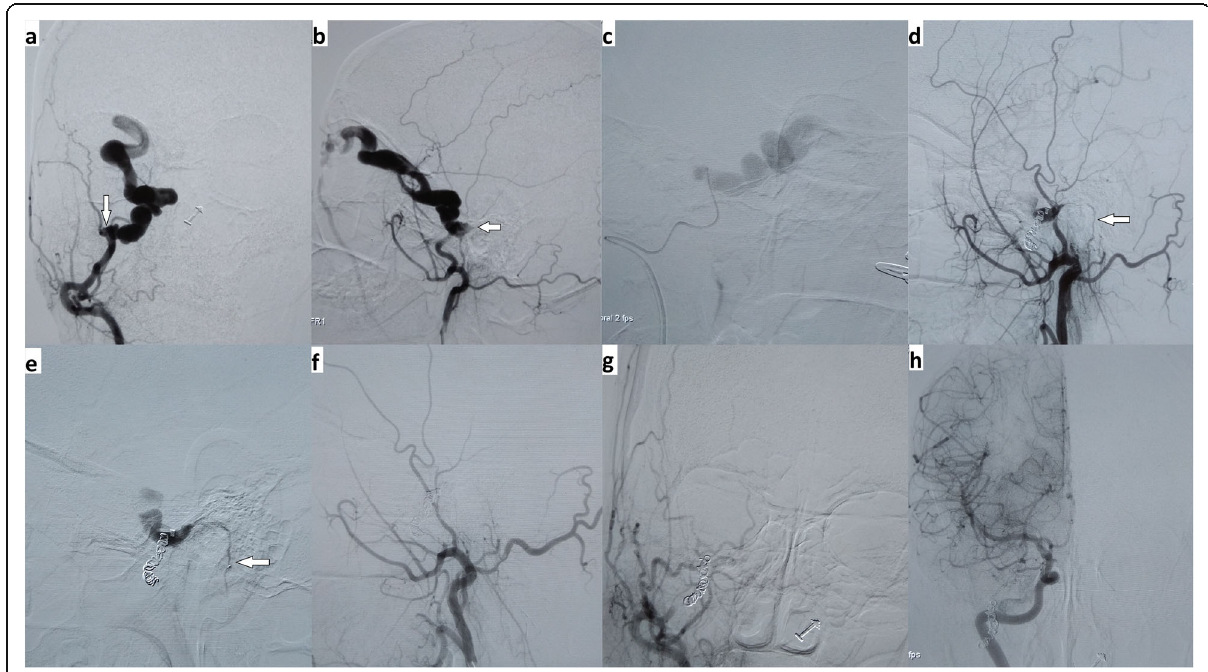
Fig. 3 DSA images in AP ( a ) and lateral ( b ) projections show type C indirect CCF with fistulous connection at foramen spinosum level (arrow). c Super-selective cannulation with tip of microcatheter at fistula site. d Post coiling DSA shows residual filling from a thin branch of the right occipital artery (arrow in d ). e Super-selective cannulation of the tiny feeder with another microcatheter (arrow in e ). Post embolization DSA images in AP ( f ) and lateral ( g ) projections show non-filling of the fistula. h DSA image showing normal opacification of right ICA